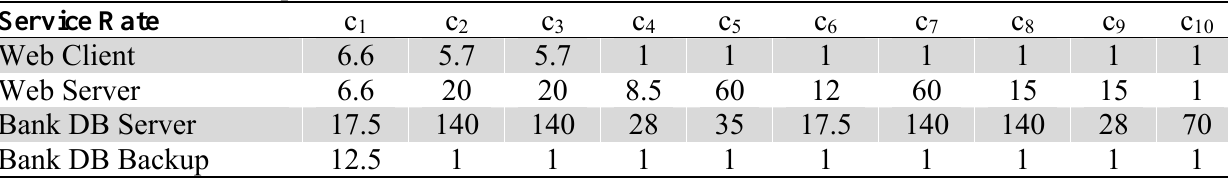
The service rate values per each resource